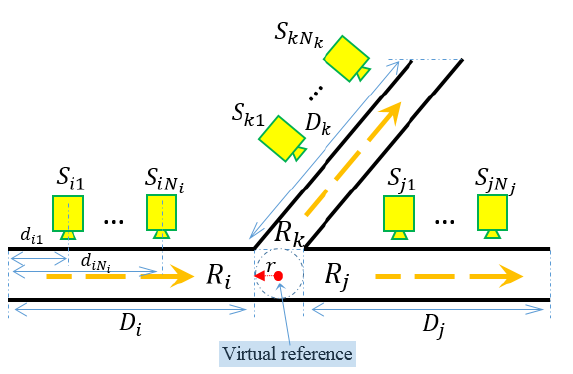
Figure 5. An intersection consists of three road segments denoted as R i , R j , and R k . The virtual reference for data preprocessing is in the center of the intersection with a radius of r to each road segment ending